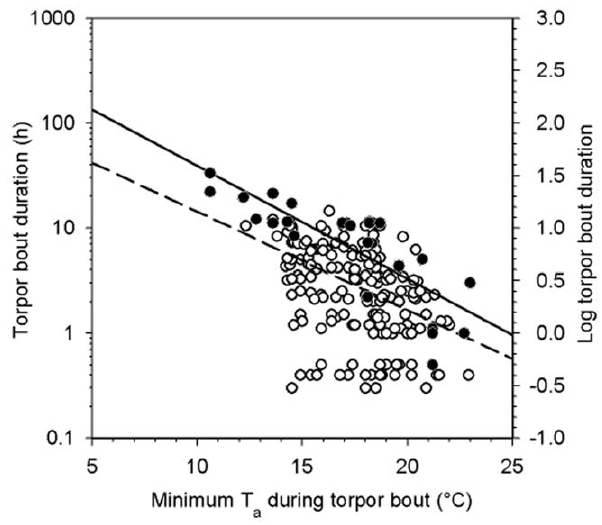
Figure 2. Duration of torpor bouts (log 10 ) as a function of the minimum T a of each torpor bout. All torpor bouts recorded are represented by the open circles and dashed line (log 10 TBD=2.1– 0.09[T a u C]; R 2 =0.2, P , 0.001, F 1,209 =55.0). The two longest bouts recorded for each individual are represented by the closed circles and